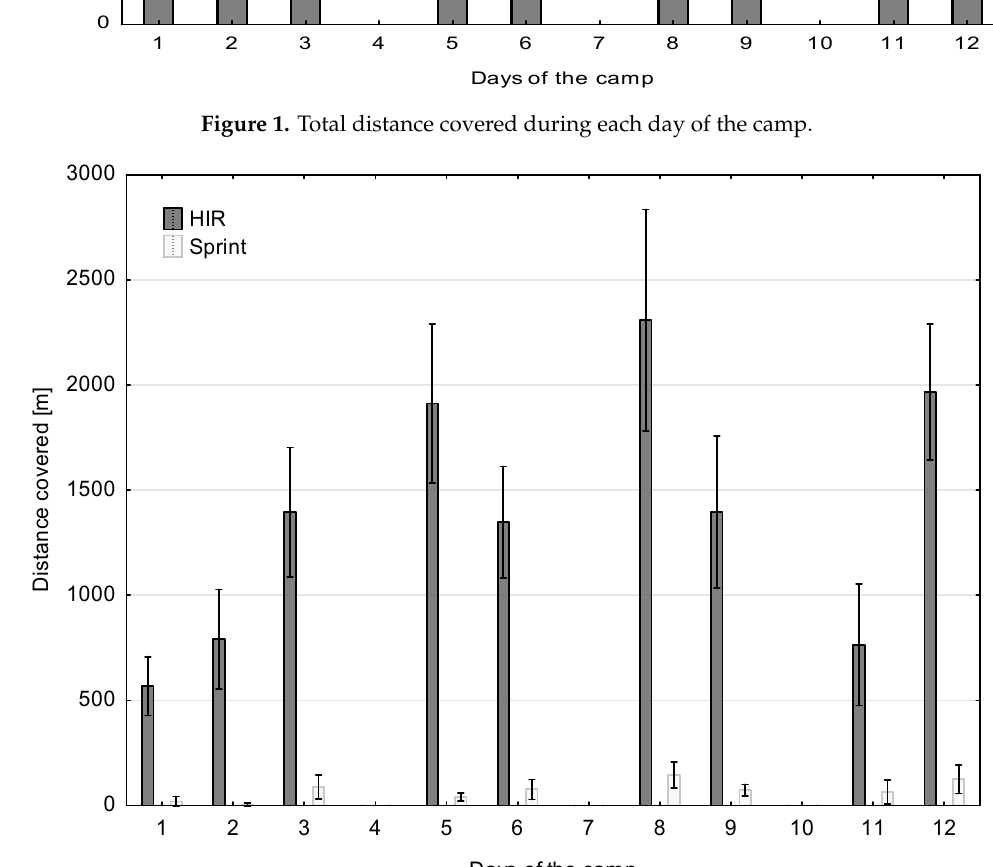
Figure 2. Distance covered in high intensity running (HIR) and sprinting during each day of the camp.